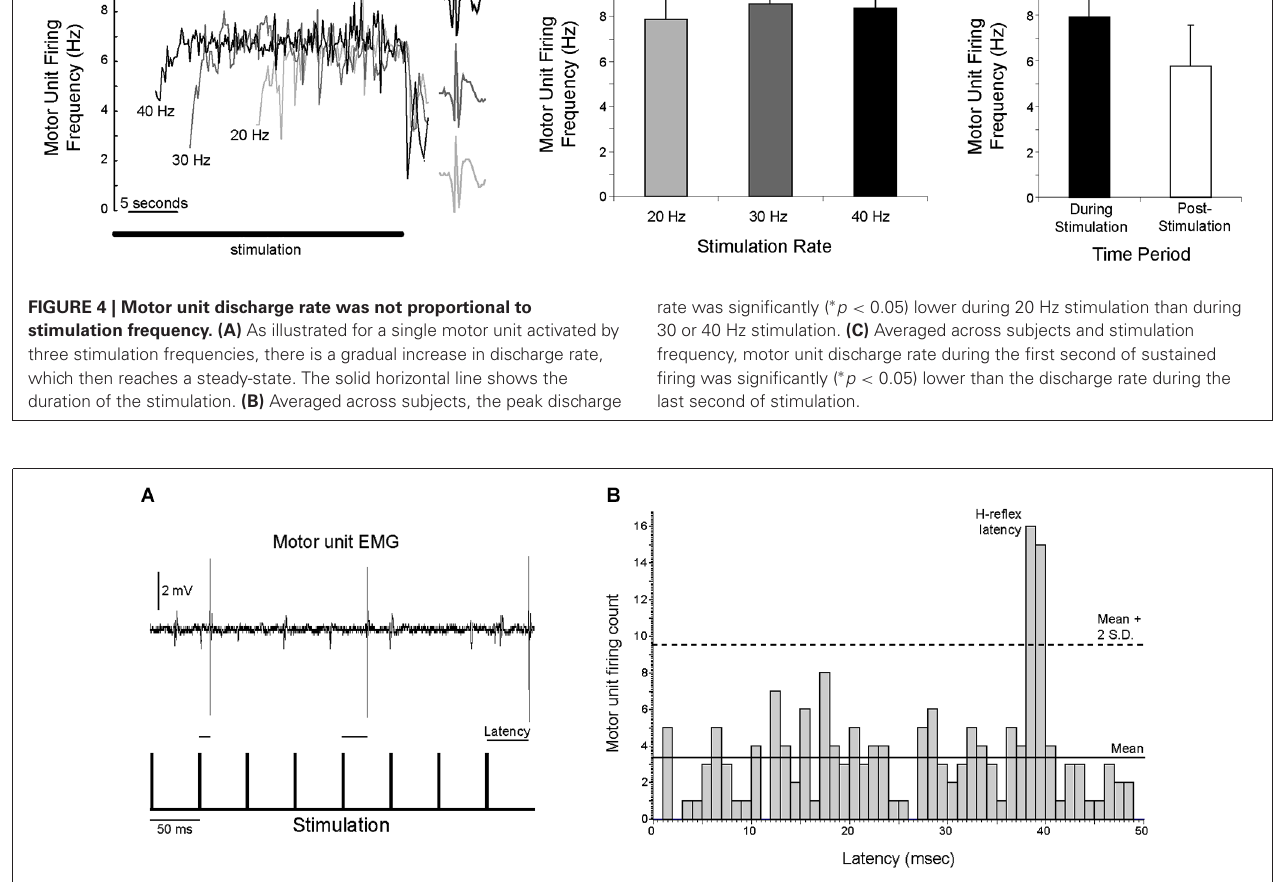
FIGURE 5 | Motor unit activity is only partially asynchronous from the stimulation pulses. (A) The latencies between motor unit discharges and the previous stimulation pulses were quantified for the nine motor units that were recruited with a stimulation frequency of ≤ 20 Hz, as illustrated for an excerpt of activity for a single motor unit. (B) Motor units